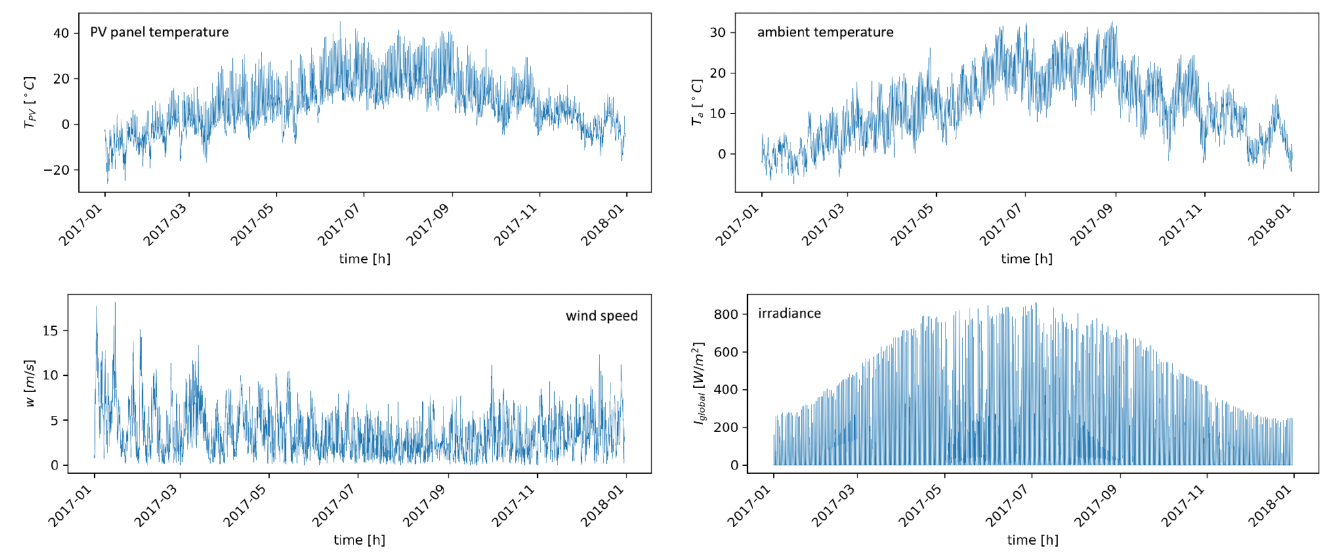
Figure 6. Meteorological